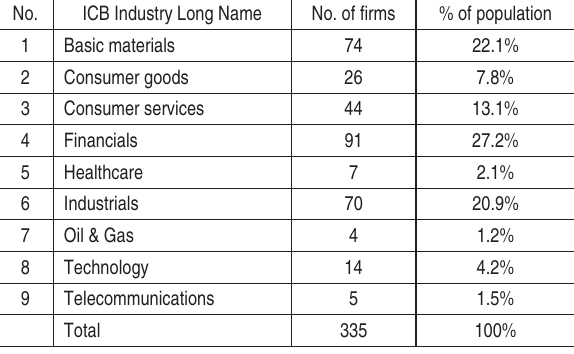
Table 1. Categories of firms listed on the JSE main